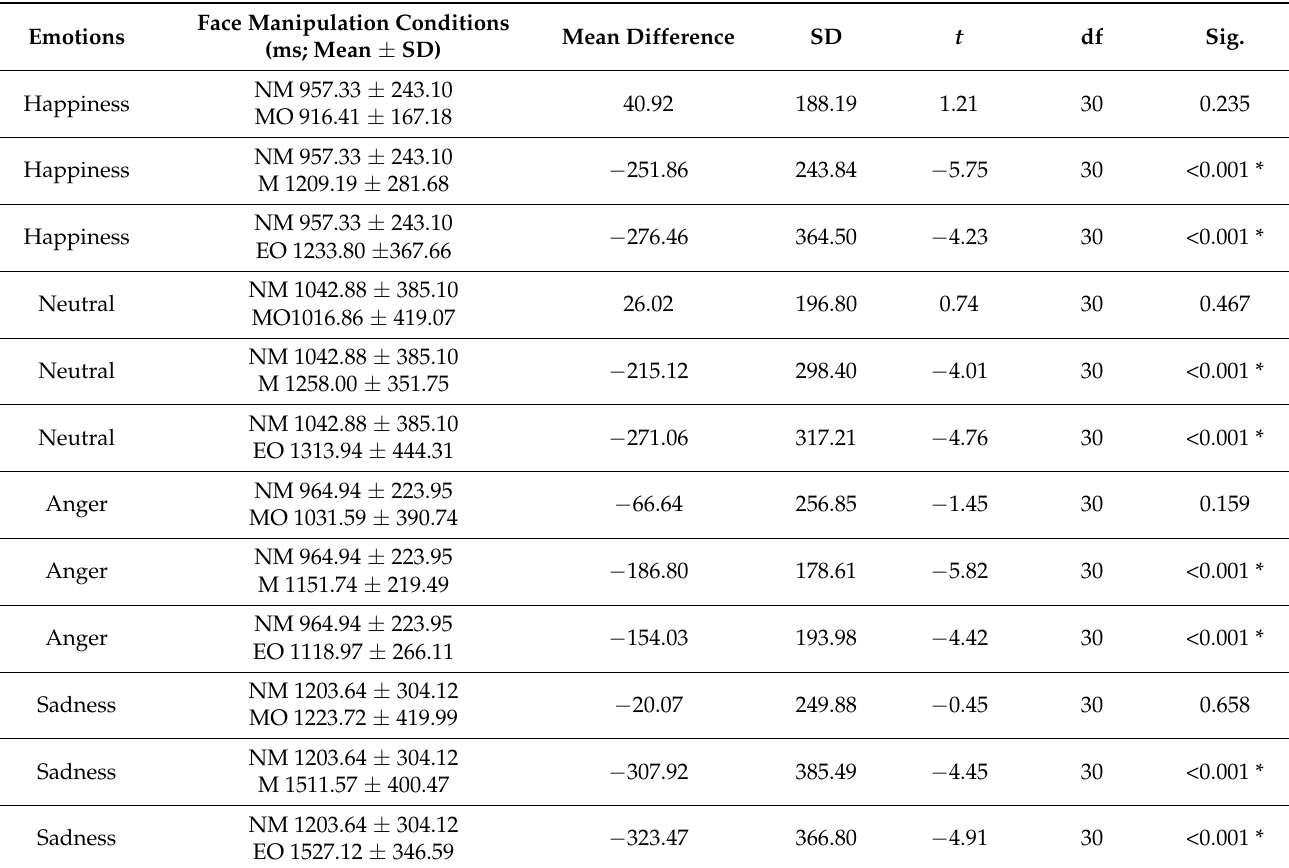
Table 3. Post hoc comparisons of reaction times for correct responses